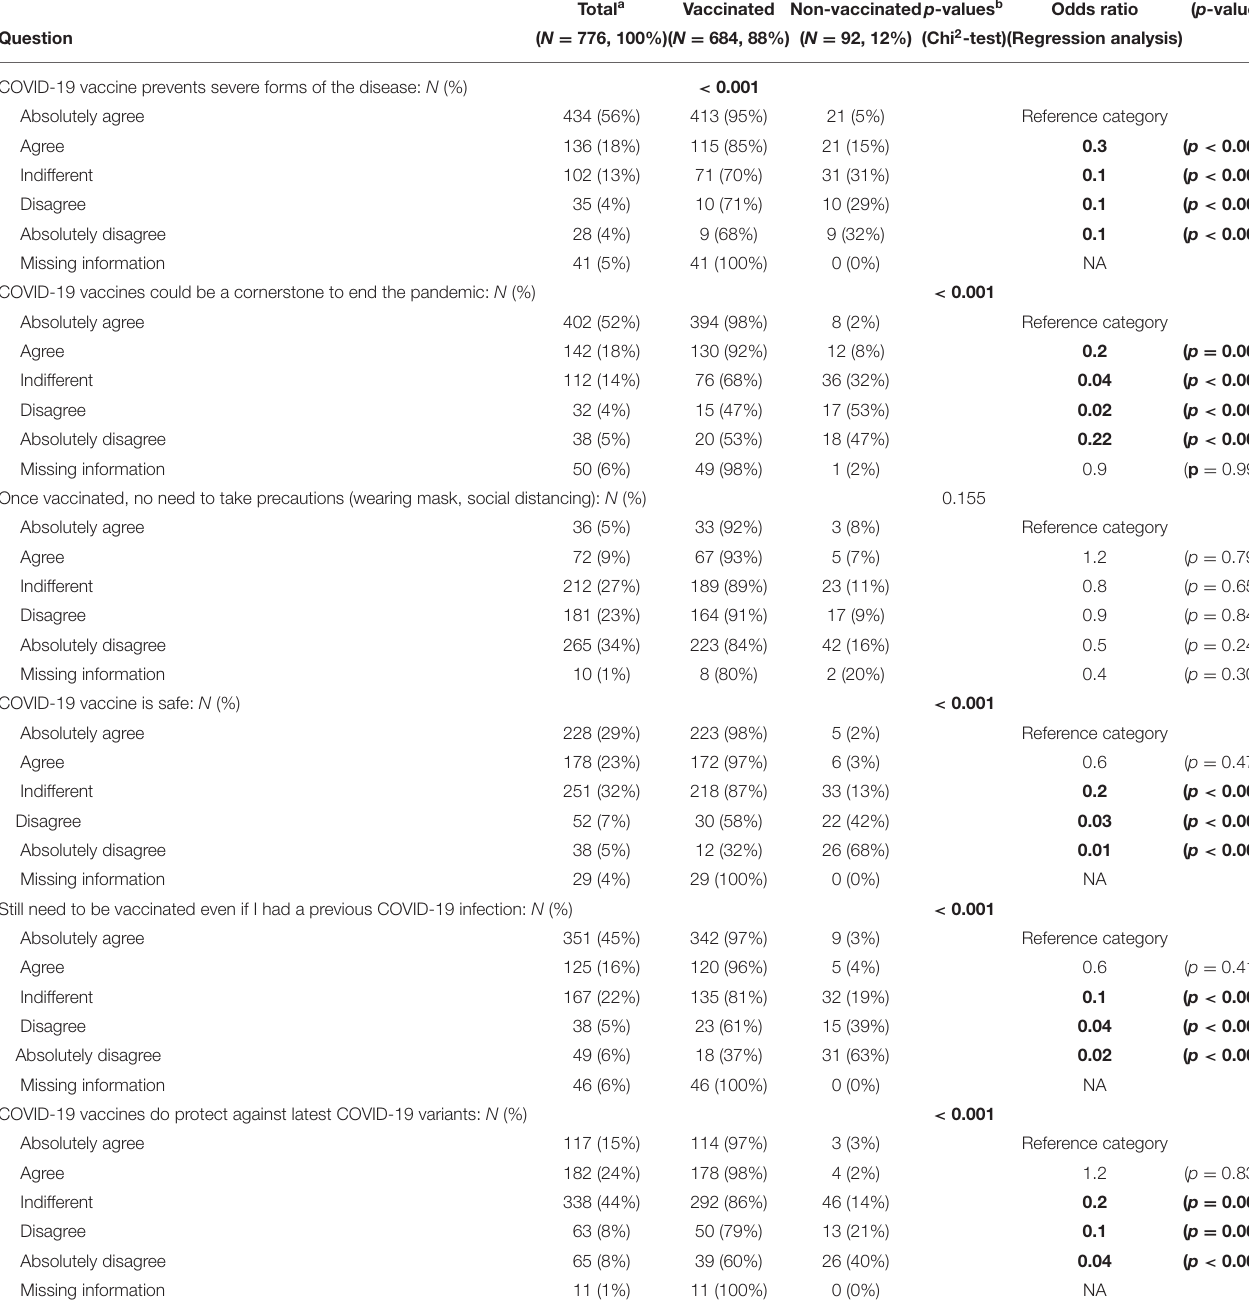
Total a Vaccinated Non-vaccinated p -values b Odds ratio ( p